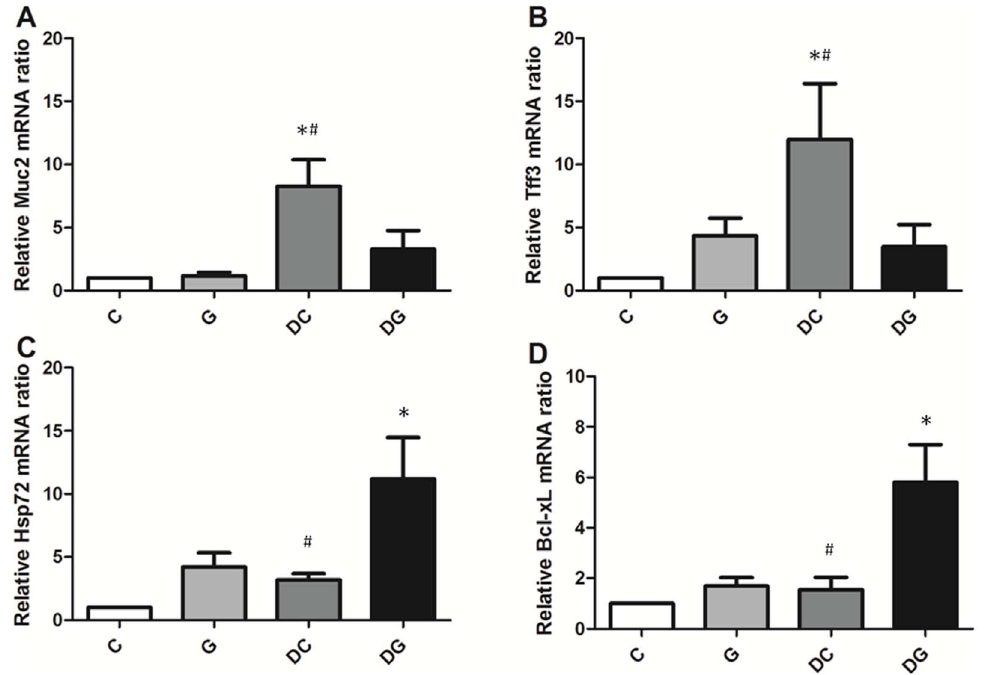
Figure 4. mRNA expressions of mucosal recovery-related and antiapoptotic genes in colon tissues. mRNA levels were analyzed by a real- time PCR. A: Expression of Muc2 mRNA. B: Expression of Tff3 mRNA. C: Expression of Hsp72 mRNA. D: Expression of Bcl-xL mRNA. Quantitation of mRNA changes was calculated by the comparative CT (2 2 DD Ct ) method, and mRNA expression of C mice was used as a calibrator. Data are shown as the mean 6 SEM. *Significantly differs from the C group. # Significantly differs from the DG group (P , 0.05).